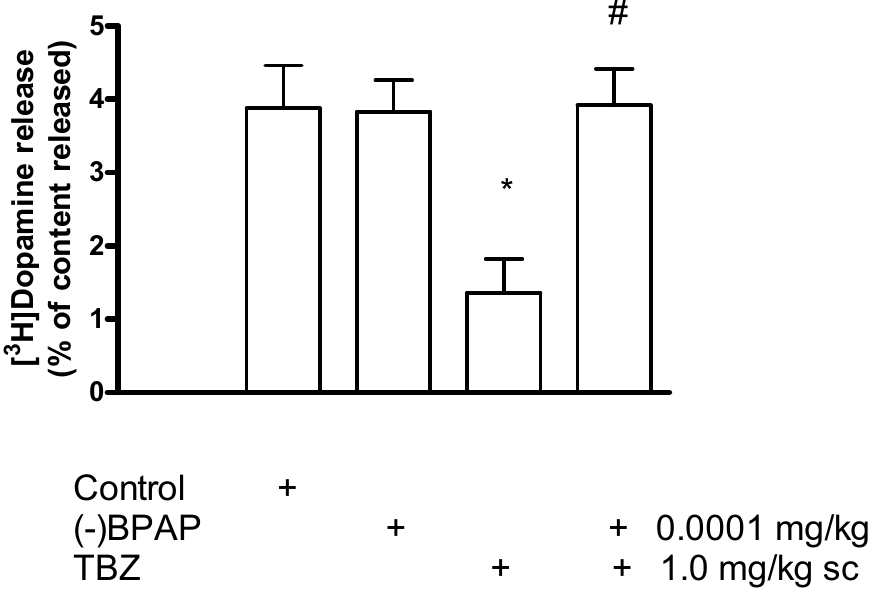
Figure 20. ( − )BPAP reversed tetrabenazine (TBZ)-induced inhibition of [ 3 H]dopamine release from rat striatum. Rats were injected with saline, TBZ (1 mg/kg), ( − )BPAP (0.0001 mg/kg), and TBZ (1 mg/kg) plus ( − )BPAP (0.0001 mg/kg) sc 60 min before the experiments. Striatal slices were prepared, loaded with [ 3 H]dopamine and superfused. The resting and the electrical stimulation (40 V, 10 Hz, 2-msec for 3 min in fraction 4)-induced [ 3 H]dopamine release was determined. Electrical stimulation markedly increased the release of [ 3 H]dopamine from striatal slices obtained from saline-treated rats, this release was inhibited by injection of TBZ. ( − )BPAP reversed the inhibitory effect of TBZ on [ 3 H]dopamine release in the striatum of rats concomitantly treated with the two drugs. ( − )BPAP treatment did not alter electrical stimulation-induced [ 3 H]dopamine release. One-way ANOVA fol- lowed by the Dunnett’s test, F(3,26) = 8.617, p = 0.0004, saline vs. TBZ pretreated groups * p < 0.01. Student t -statistics for two means, TBZ vs. TBZ and ( − )BPAP effect # p < 0.001, mean ± S.E.M., n = 7-